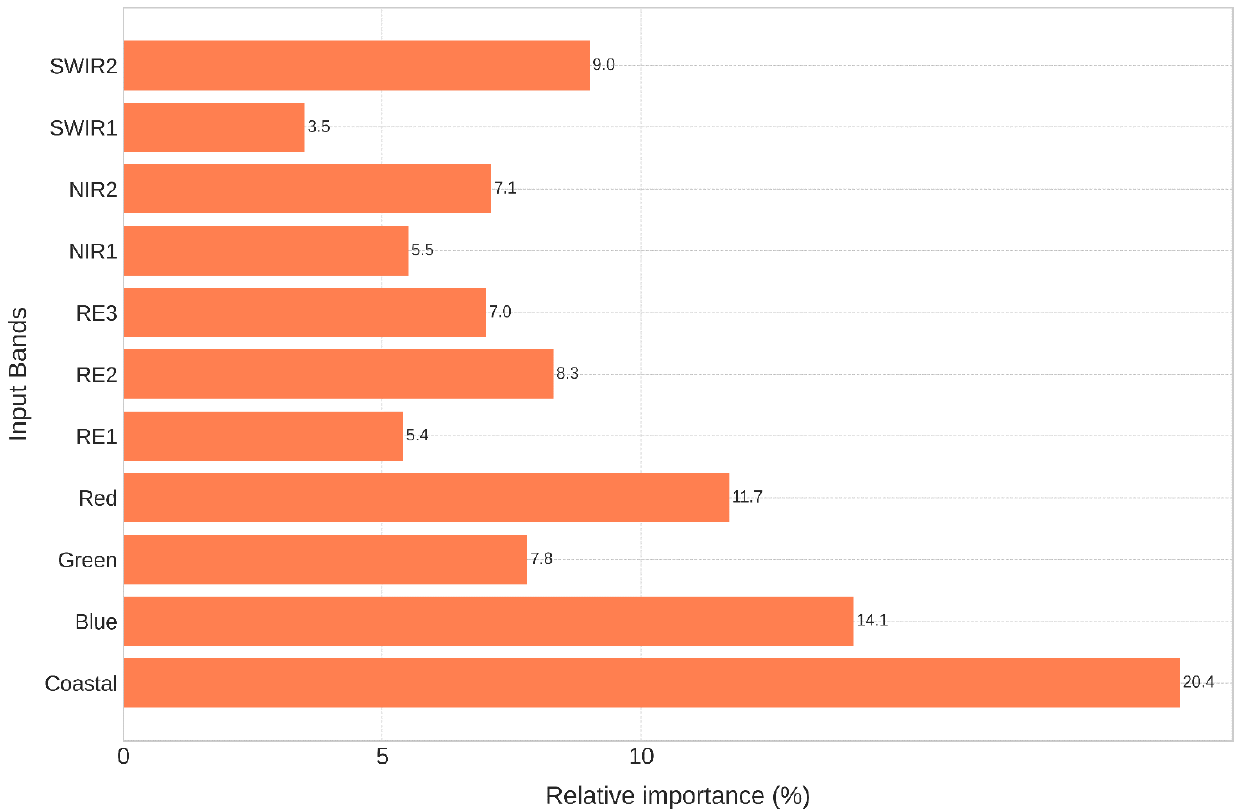
Figure 4. Contribution of features in lotus mapping derived from the sGTB model.